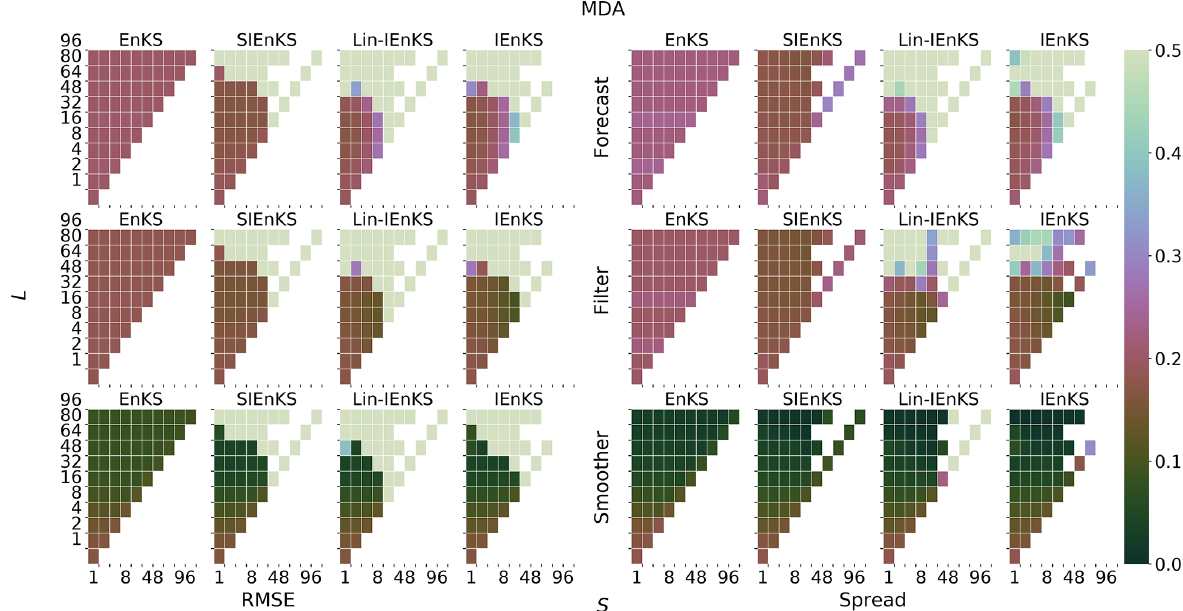
Figure 19. Lag length L on the vertical axis and shift S on the horizontal axis. MDA, tuned inflation, linear observations, ensemble size N e = 21, and (cid:49)t = 0 . 05 are indicated. The EnKS SDA results are presented here for